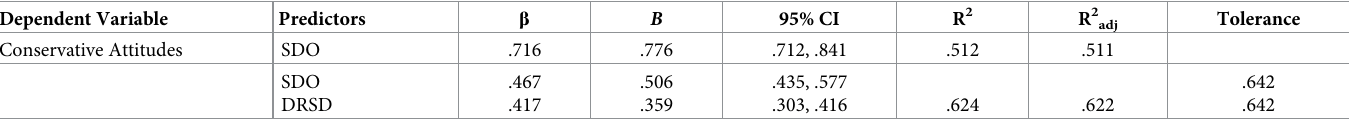
Table 6. Regression Analyses predicting conservative